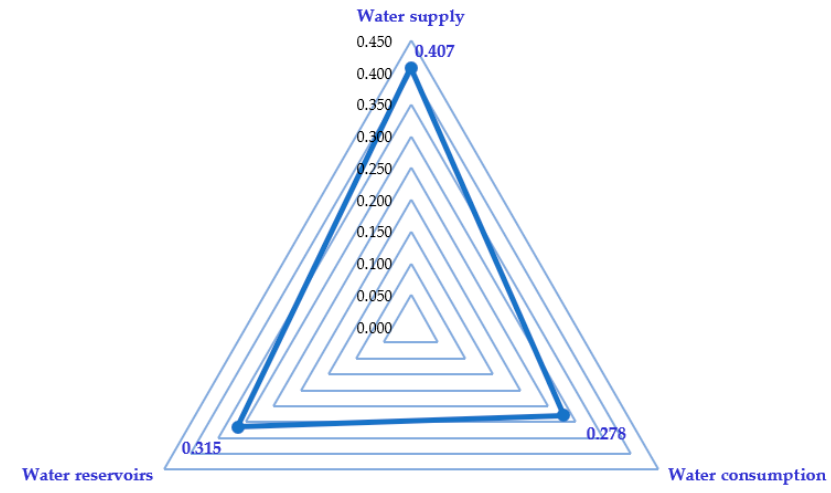
Figure 11. Relative weights of the assessment indicators for “Water Use”.